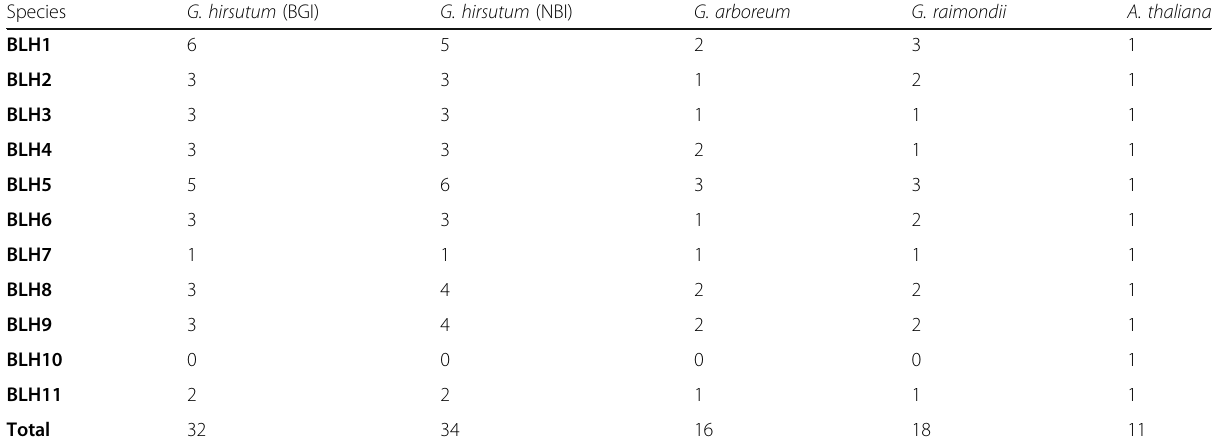
Table 1 The BLH family members of G. hirsutum , G. arboreum , G. raimondii, and A. thaliana Species